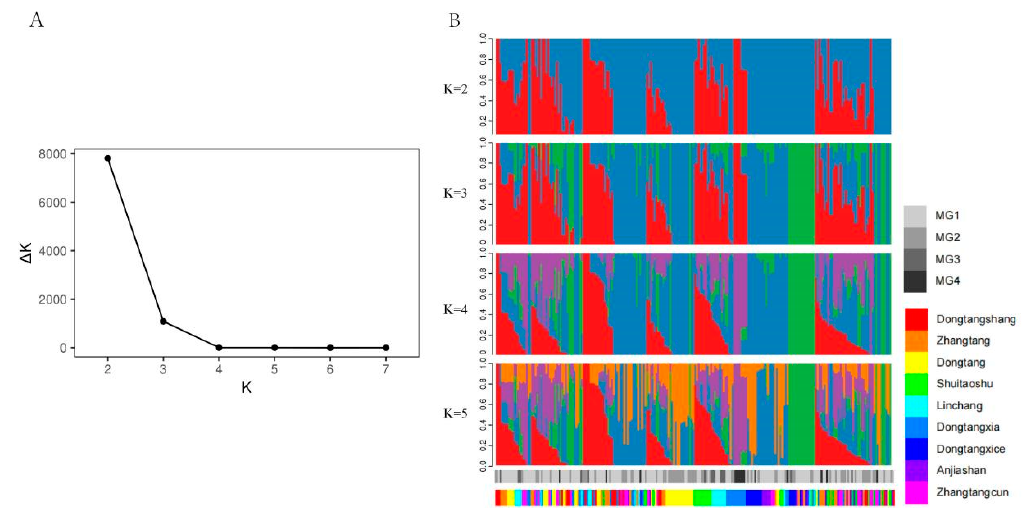
Figure 5. The Δ K trends ( A ) and the population structure ( B ) with different K values for the DXWR. MG1: G1 subpopulations in mitochondrial markers grouping, MG2: G2 subpopulations in mitochondrial markers grouping, MG3: G3 subpopulations in mitochondrial markers grouping, MG4: G4 subpopulations in mitochondrial markers grouping.